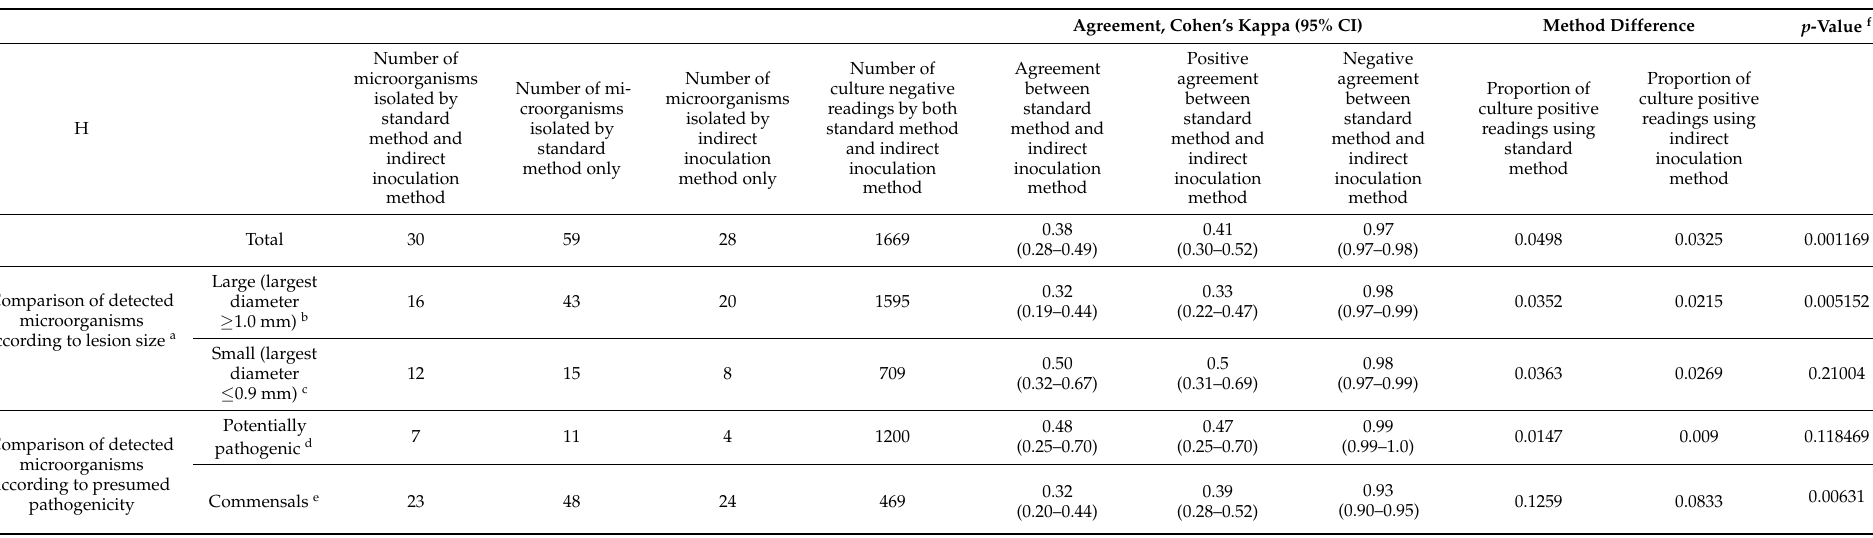
Table 2. Agreement and differences between the standard corneal culture method and the indirect inoculation method for microorganisms isolated from infectious